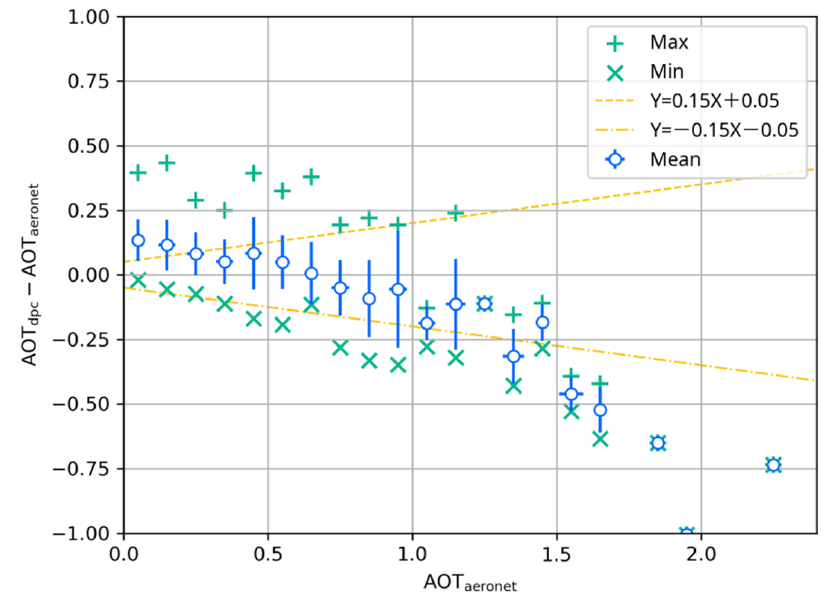
Figure 3. Absolute error of total AOD. The x ‐ axis is the AOD AERONET , and the y ‐ axis is the absolute AOD difference (AOD DPC —AOD AERONET ). The means and standard deviations of DPC retrievals are the blue diamonds and top ‐ bottom error bars in the vertical. The plus and cross signs are the maximum and minimum values of DPC retrievals. The yellow lines represent the EE for total AOD ± (0.05 + 0.15).